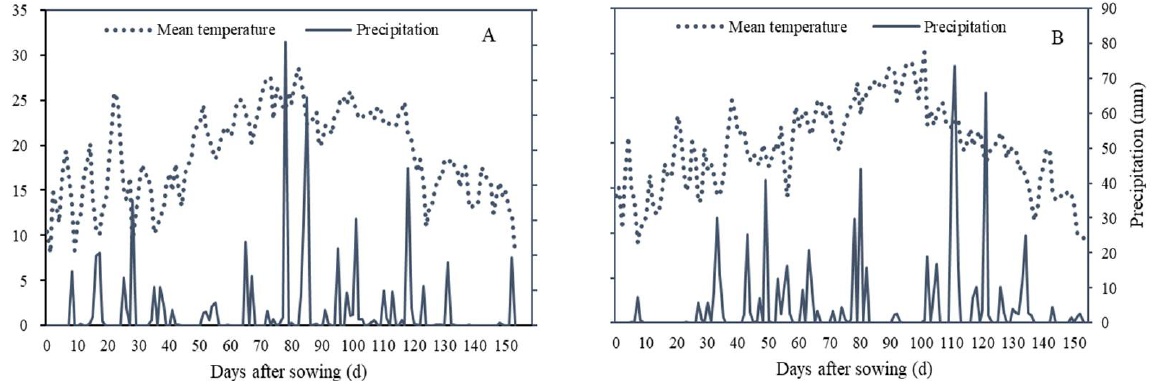
Figure 1. Daily mean temperature and daily precipitation in 2019 ( A ) and 2020 ( B ) growing seasons.